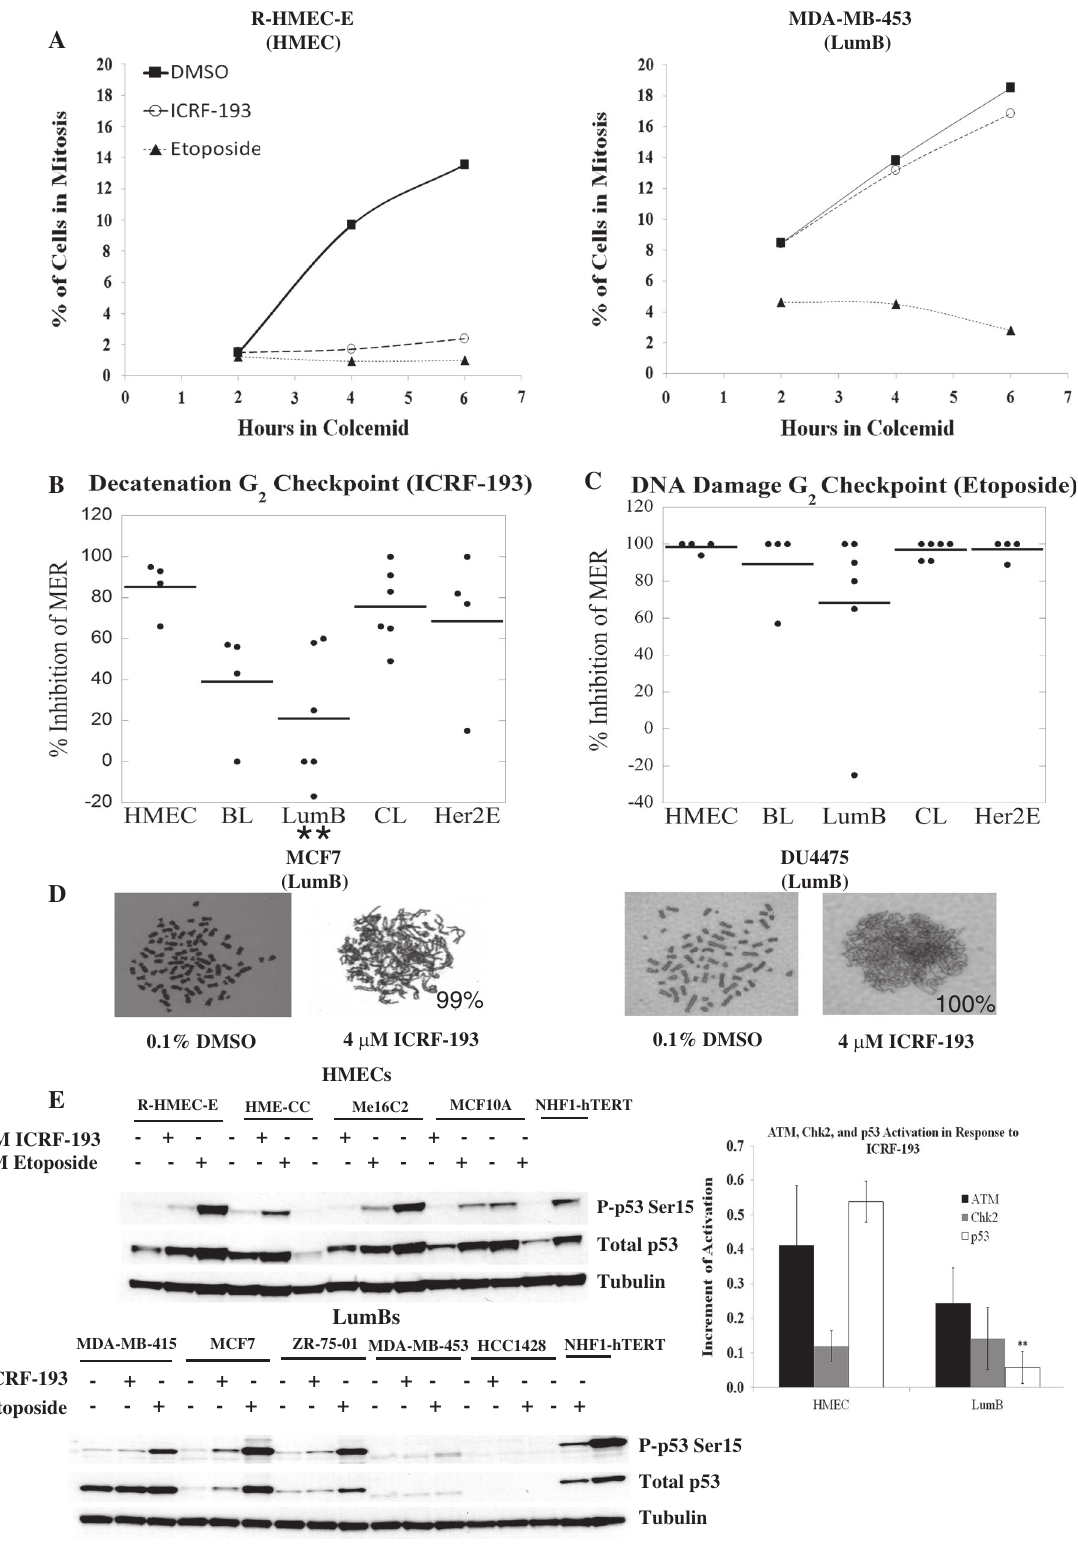
functions were assessed in a panel of 24 cell lines using a fl ow cytometry-based mitotic entry rate (MER) assay that allows for discrimination among three molecularly distinct G 2 /M check- points: the DNA damage G 2 checkpoint, the decatenation G 2 checkpoint, and the SAC. The panel is comprised of cell lines